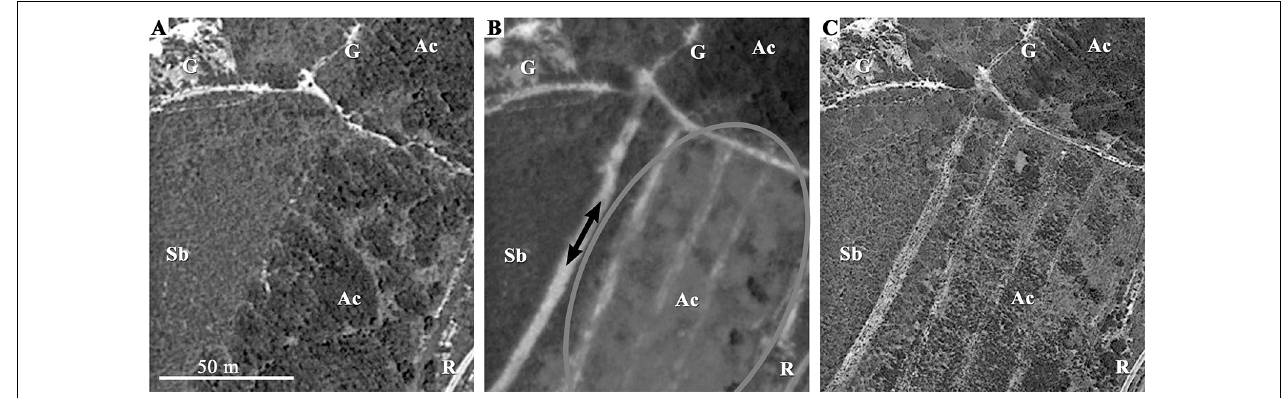
FIGURE 3 | Aerial view of the habitat invaded by Acacia sp. with the chronological sequence of its partial removal. (A) May 2010: the invasive species ( Ac ) has occupied a large ( > 50 m) ribbon next to a dirt road ( R ) parallel to the coast. The native shrubland ( Sb ) as well as large gaps ( G ), where Plantago almogravensis ought to be found, are visible on the coast side ( left ). (B) April 2011: an area of approx. 50 m × 100 m of the Acacia sp. stand was cleared ( oval ) and P. almogravensis was later observed flowering on the cleared area ( black arrows ). (C) May 2013: the cleared area is still visible, but either Acacia sp. or other plants, rather than the native shrubland, are developing. Images:© DigitalGlobe/Google Earth 2015. Figure adapted from Serrano (2015), p. 155.